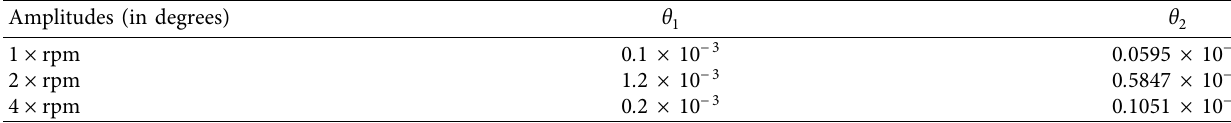
Table 9: Angular spectrum of the system including imbalance and